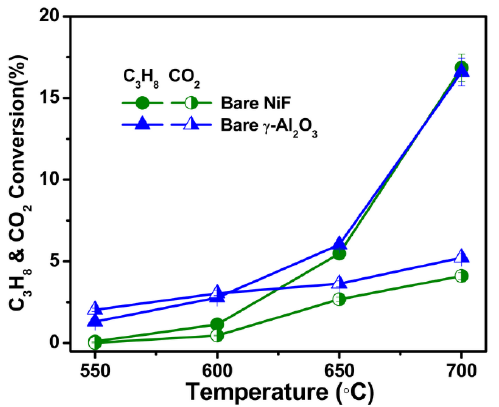
Figure 7. Catalytic activity of DRP as a function of temperature over bare supports γ- Al 2 O 3 and NiF at 550 °C to 700 °C under atmospheric pressure in CPR = 3 (30:10:60 CO 2 :C 3 H 8 :Ar), and total flow rate = 200 mL/min, C 3 H 8 and CO 2 conversion.